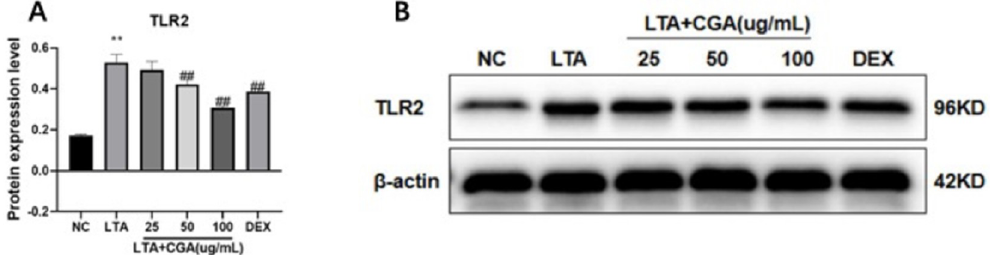
Fig 6. Effect of chlorogenic acid (CGA) on toll-like receptor 2 (TLR2) expression. The expression of TLR2 in BMECs was analyzed via Western blot. β -actin was used as a reference control. Dexamethasone (DEX) was used as a positive control. (A) The quantification histogram of TLR2 protein expression normalized by β -actin. The values presented are the mean ± SE of three independent experiments. �� p < 0.01 vs. control group; ## p < 0.01 vs. LTA group. (B) The expression levels TLR2. Original blots are presented in S1, S2 Figs in S1 Raw images. NC: normal control; LTA: lipoteichoic acid; LTA+CGA: lipoteichoic acid and chlorogenic acid; DEX: Dexamethasone.